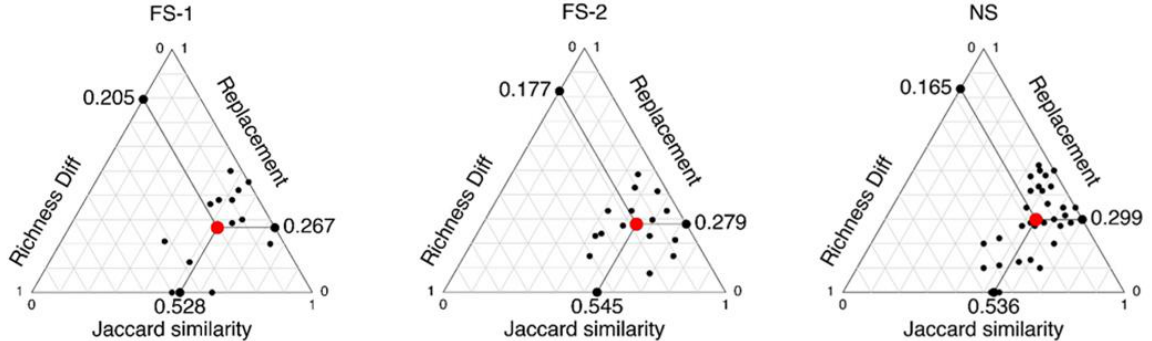
Figure 6. Simplex plots based on similarity, richness differences, and species replacement for all the pairwise comparisons of the contemporary Cladocera assemblage of the three sites of the oxbow lake. Three sites: fishing site-1 (FS-1), natural site (N.S.), fishing site-2 (FS-2).